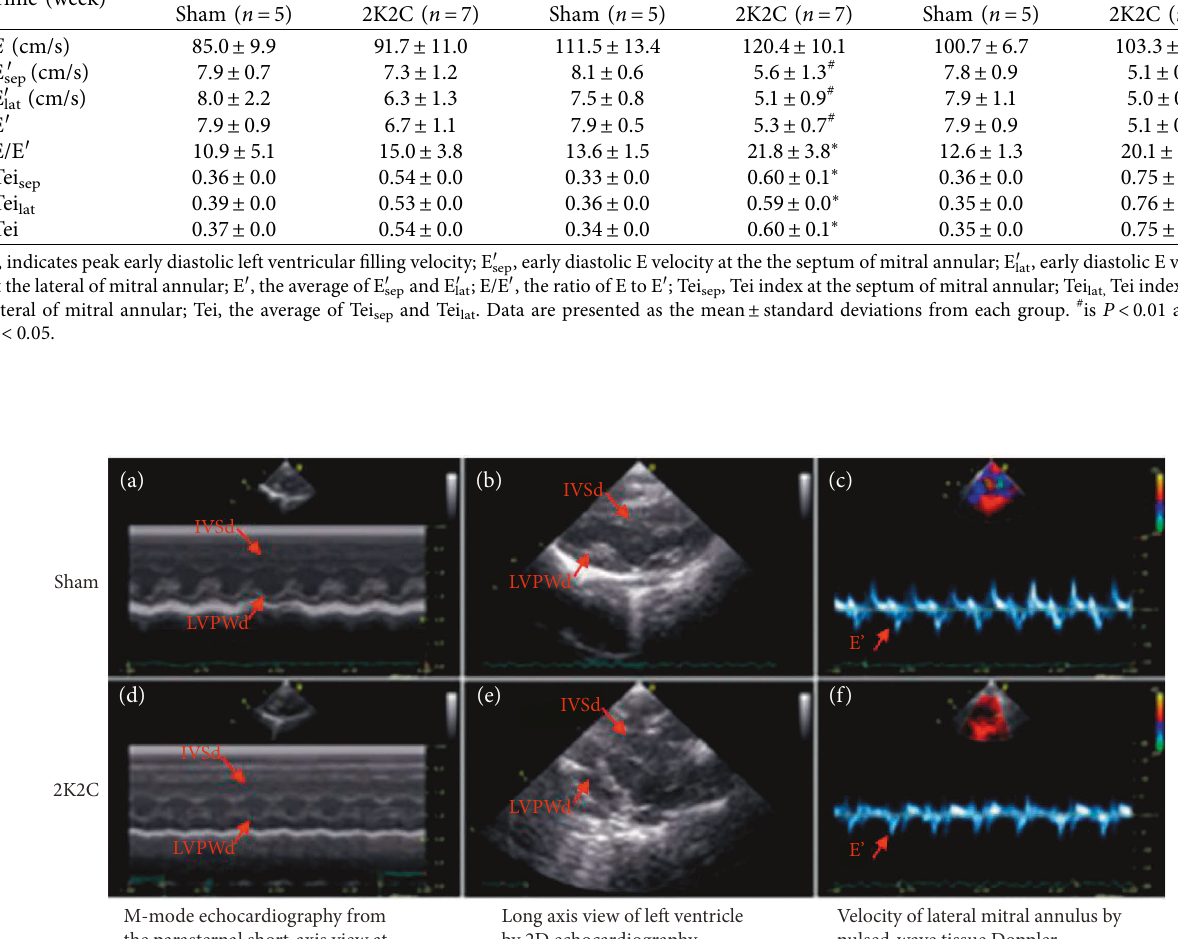
Table 2: Doppler Measurements of E / E ′ and Tei index.